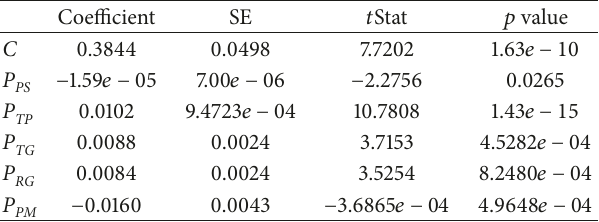
Table 3: Linear regression model of packet delivery ratio.